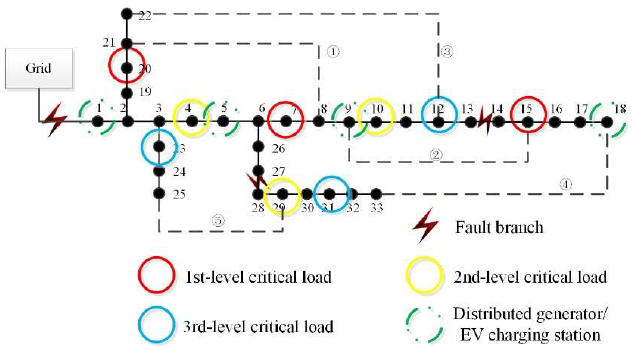
Figure 5. Schematic diagram of IEEE 33-bus system.